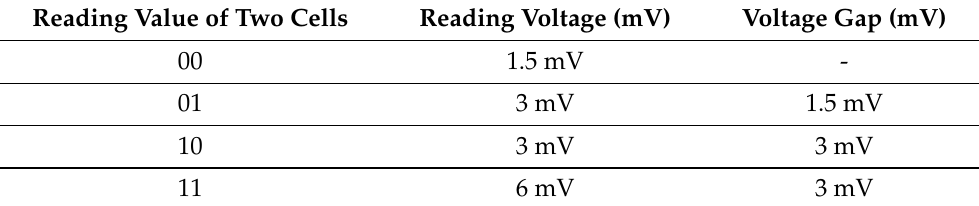
Figure 2. Differences between circuits in ( a , b ) during execution and operation. Table 3. Read result of the circuit of Figure 1a (1: R AP = 6000 (ohm), 0: R P = 3000 (ohm), I1 = 1 µA, I0 = 0.5 mA).